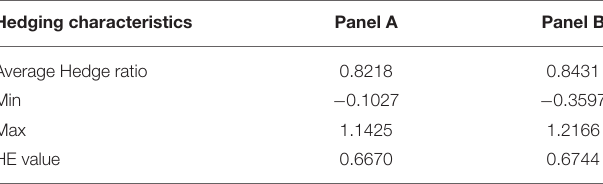
TABLE 9 | Hedging effectiveness of the Bitcoin futures to the Bitcoin spot after controlling other